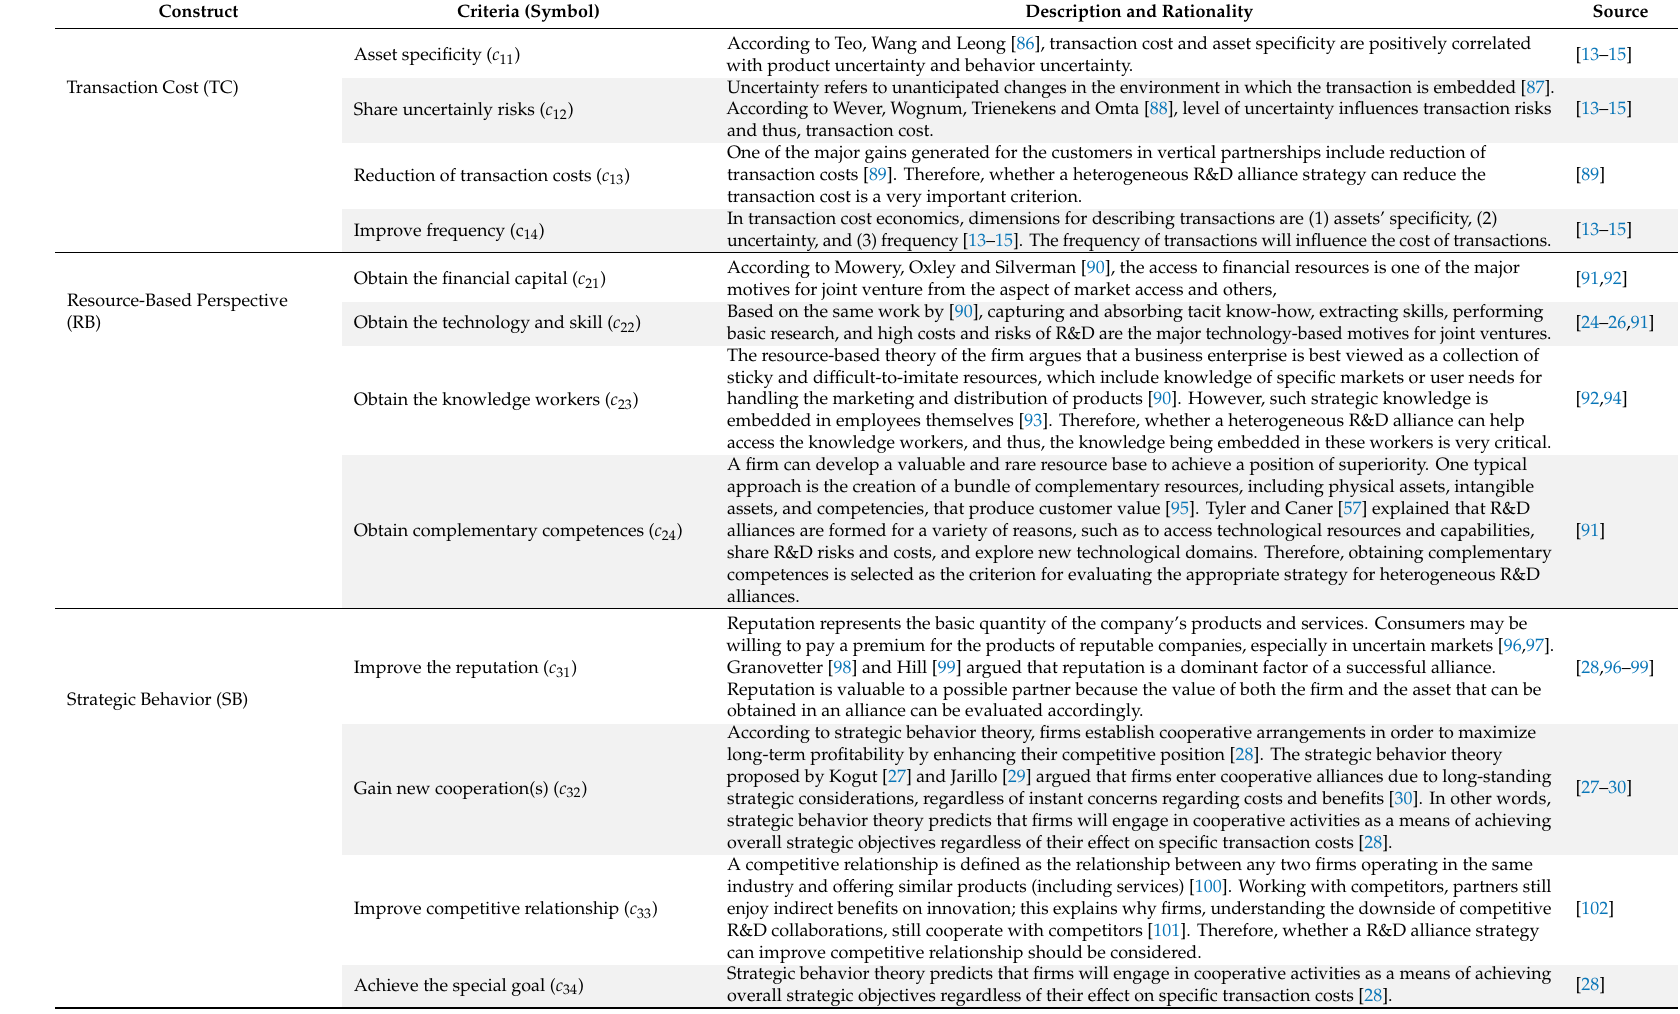
Table 1. Criteria descriptions and